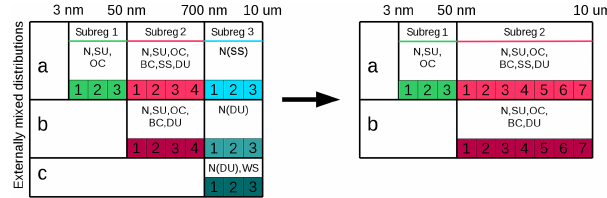
Figure 1. Particle size sections and chemical species in aerosol model SALSA. The left-hand panel illustrates the standard SALSA set-up. The rows “a”, “b” and “c” denote the externally mixed parti- cle distributions. Within each distribution and subregion, N denotes number concentration and SU, OC, BC, SS and DU respectively sulfate, organic carbon, black carbon, sea salt and dust masses, which are traced separately. Within distributions “a” and “b” in sub- region 3, only particle number concentration is tracked, and all par- ticles are assumed to be sea salt in distribution “a” (N(SS)) and dust in distribution “b” (N(DU)). In distribution “c” only number con- centration (N(DU)) and water soluble fraction (WS) are traced. The numbers at the bottom of each subregion illustrate the size sections within that subregion. In our study, the third subregion is excluded and the second subregion is broadened to cover subregion 3 size sections (right-hand